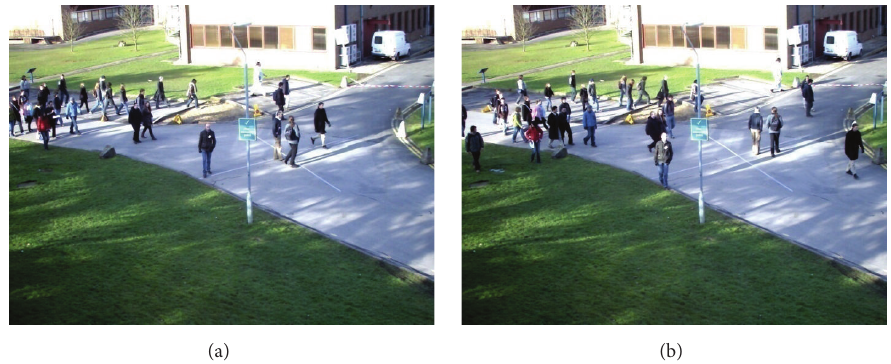
Figure 11: Sample frames from a PETS2009 dataset View 001 captured using a fixed camera.